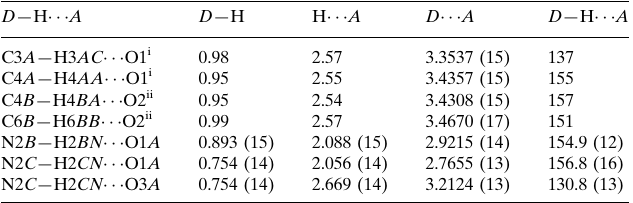
Hydrogen-bond geometry (A˚ , (cid:3)